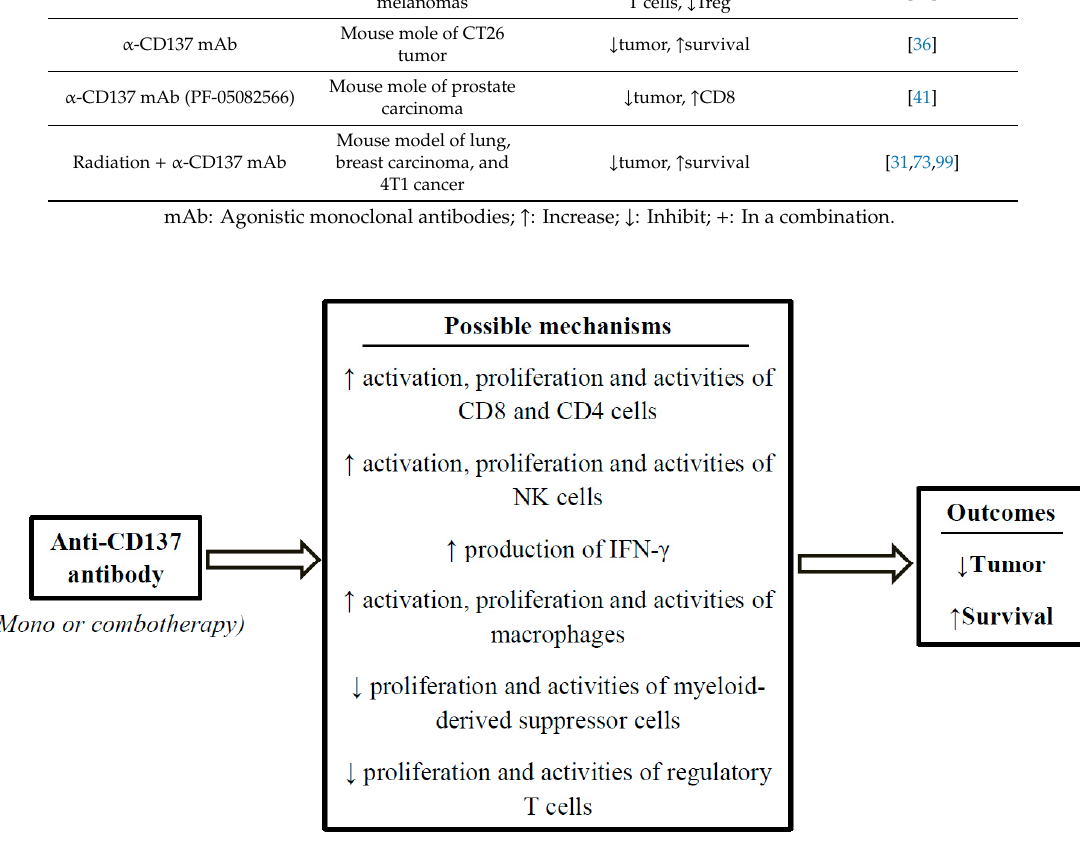
Figure 1. Schematic illustration of mechanisms underlying the anti-cancer effects of anti-CD137 antibodies in immunotherapies. Current evidence suggests that in mono or combotherapies for cancer, anti-CD137 antibodies increase anti-tumor immune response because they can activate/regulate immune subsets in the tumor microenvironment such as these antibodies increase ( ↑ ) the activation, proliferation and activities of CD8 T cells, CD4 T cells, natural killer (NK) cells and macrophages; increase IFN- γ production, but they inhibit ( ↓ ) the proliferation and functions of myeloid-derived suppressor cells and regulatory T cells.